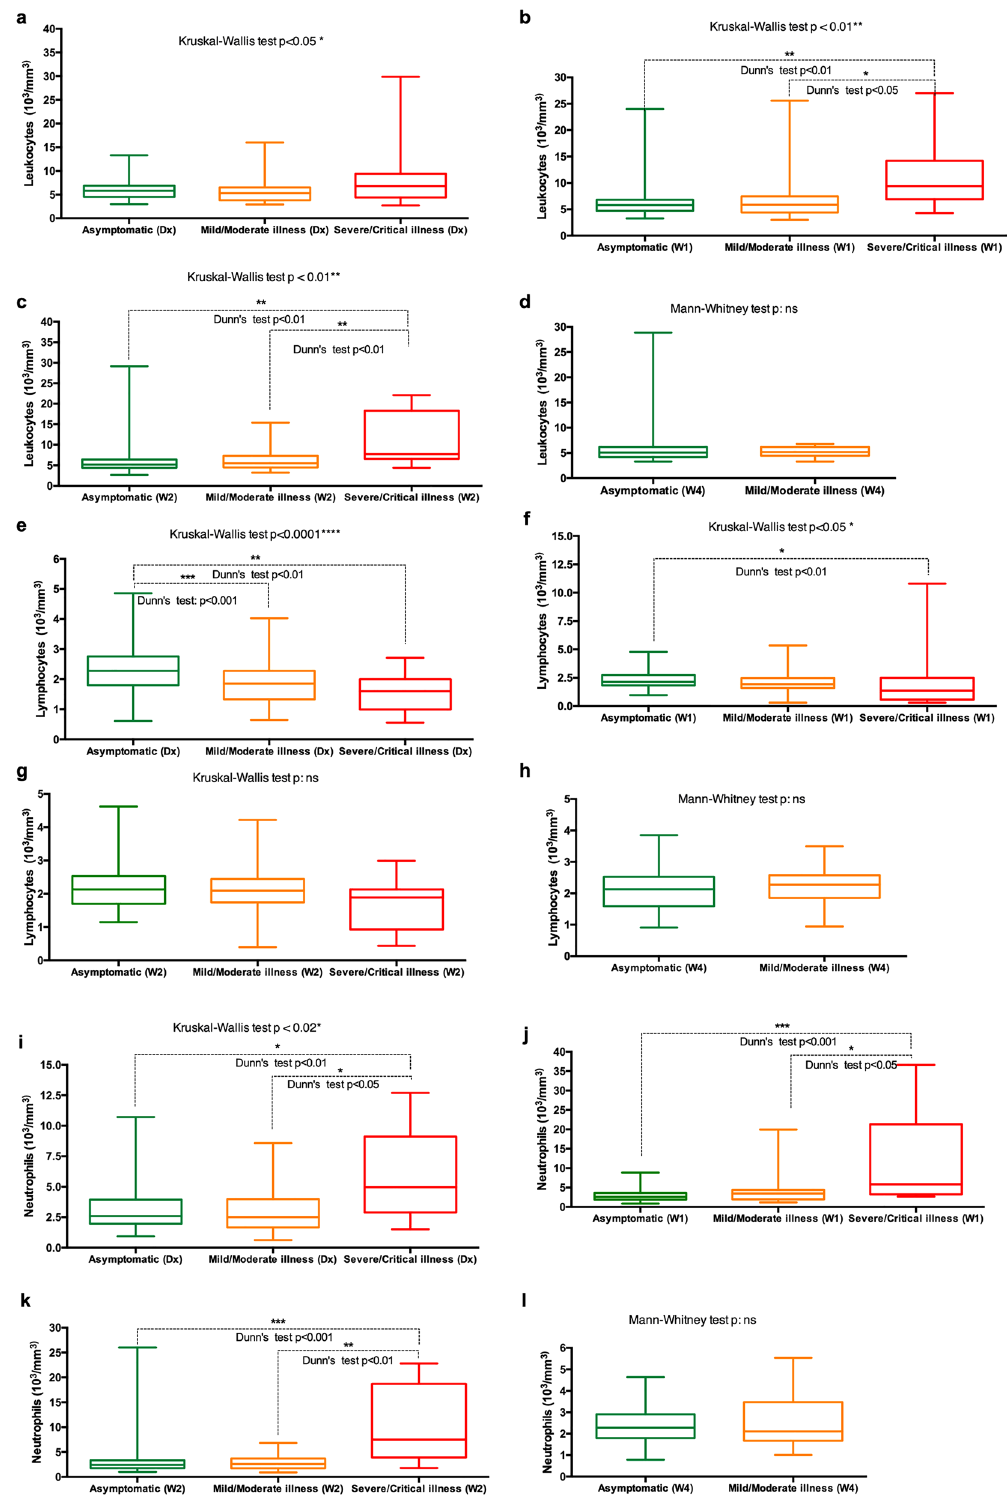
Figure 3. ( a – l ) Temporal changes in the count of leukocytes ( a – d ), lymphocytes ( e – h ) and neutrophils ( i – l ) in patients with different COVID-19 severity spectrums. Blood samples were collected and analyzed at diagnosis (Dx), week 1 (W1), week 2 (W2) and week 4